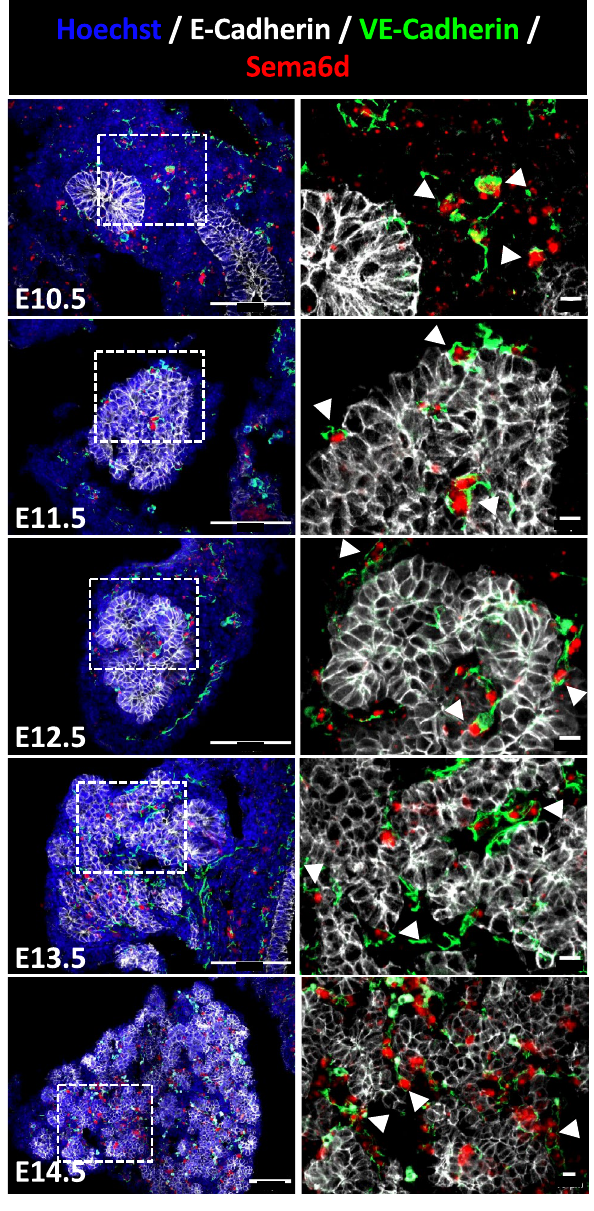
Figure 3. Localization of Sema6d expressing cells in developing pancreas. Detection of Sema6d transcripts by in situ hybridization (in red) on pancreatic tissue sections from E10.5 to E14.5, combined with an immunolabeling of E-Cadherin (white) and VE-Cadherin (green), to respectively detect the epithelium and vessels. Nuclei were counterstained with Hoechst (blue). Regions delineated by dashed lines on the left images are magnified on the right. Arrowheads indicate VE-Cadherin positive endothelial cells expressing Sema6d mRNA. Scale bars: 100 μm (at left) and 10 μm (at